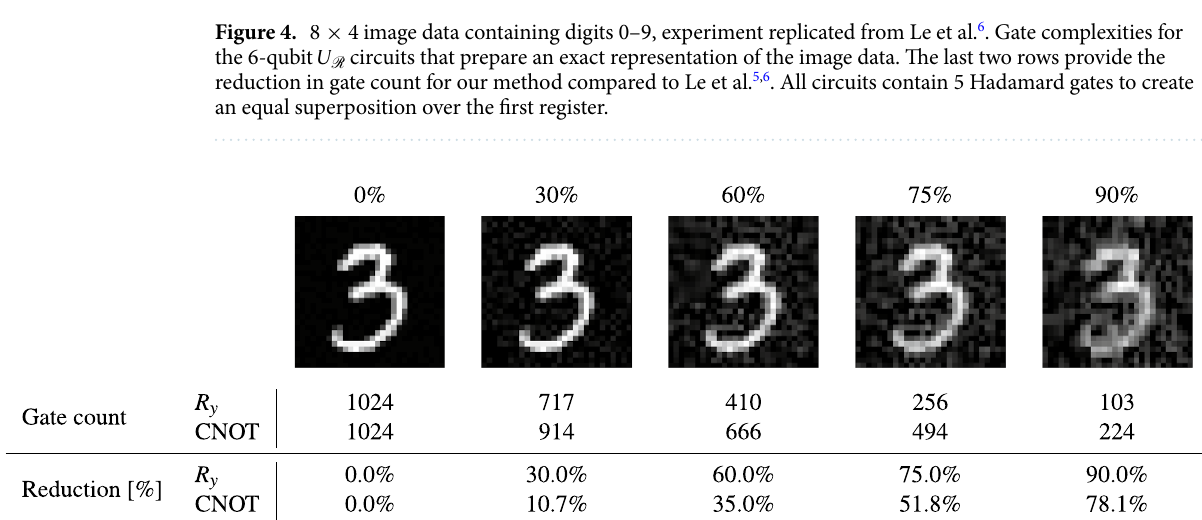
QPIXL++ at various compression